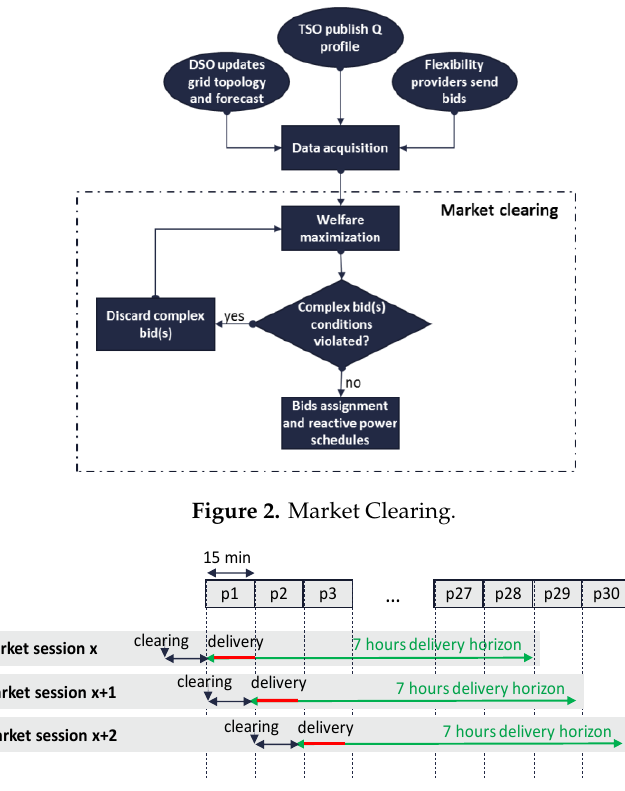
Figure 3. Time intervals and delivery horizon in a timeframe.